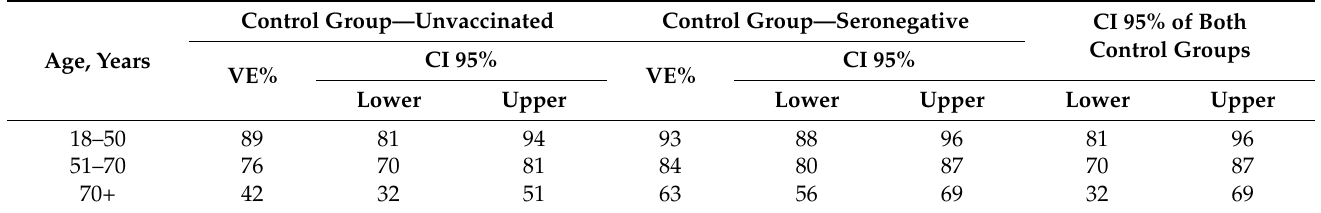
Table 1. Efficiency of the Sputnik V vaccine to prevent severe forms of COVID-19 with confidence intervals. Data obtained in Moscow in July